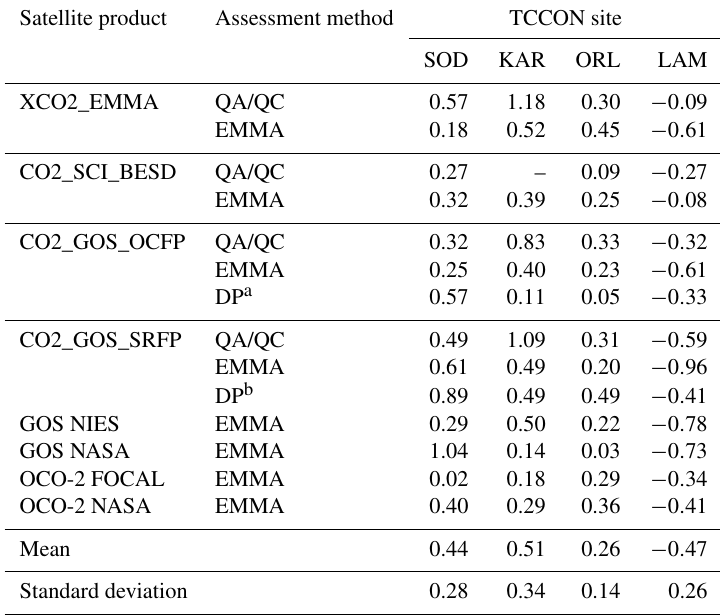
Table 6. TCCON XCO 2 bias in parts per million (ppm; satellite – TCCON). “–” means that the number of available colocations is less than the threshold required by the corresponding assessment method. Note that this table includes only a subset of the 10 sites shown in Fig. 12, namely only those sites with a mean bias being considerably (more than 1.5 times) larger than the standard deviation of the